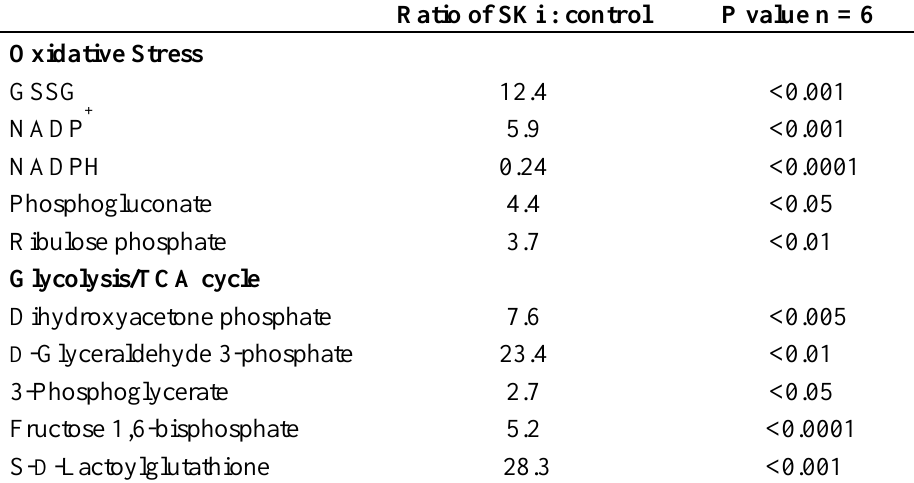
Table 1. Effect of SKi (10 μM, 24 h) on metabolite levels in LNCaP-AI cells. Results are expressed as the ratio SKi:control for each metabolite. P values are presented for SKi vs. control (experimental results from n = 6 cell samples for each